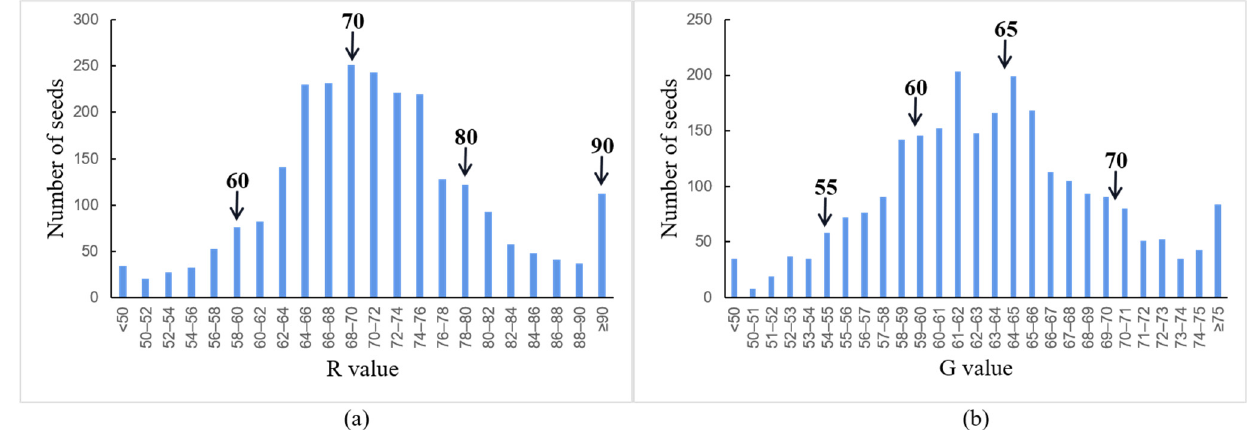
Figure 1. A frequency histogram of the R value ( a ) and G value ( b ) of Astragalus seeds.